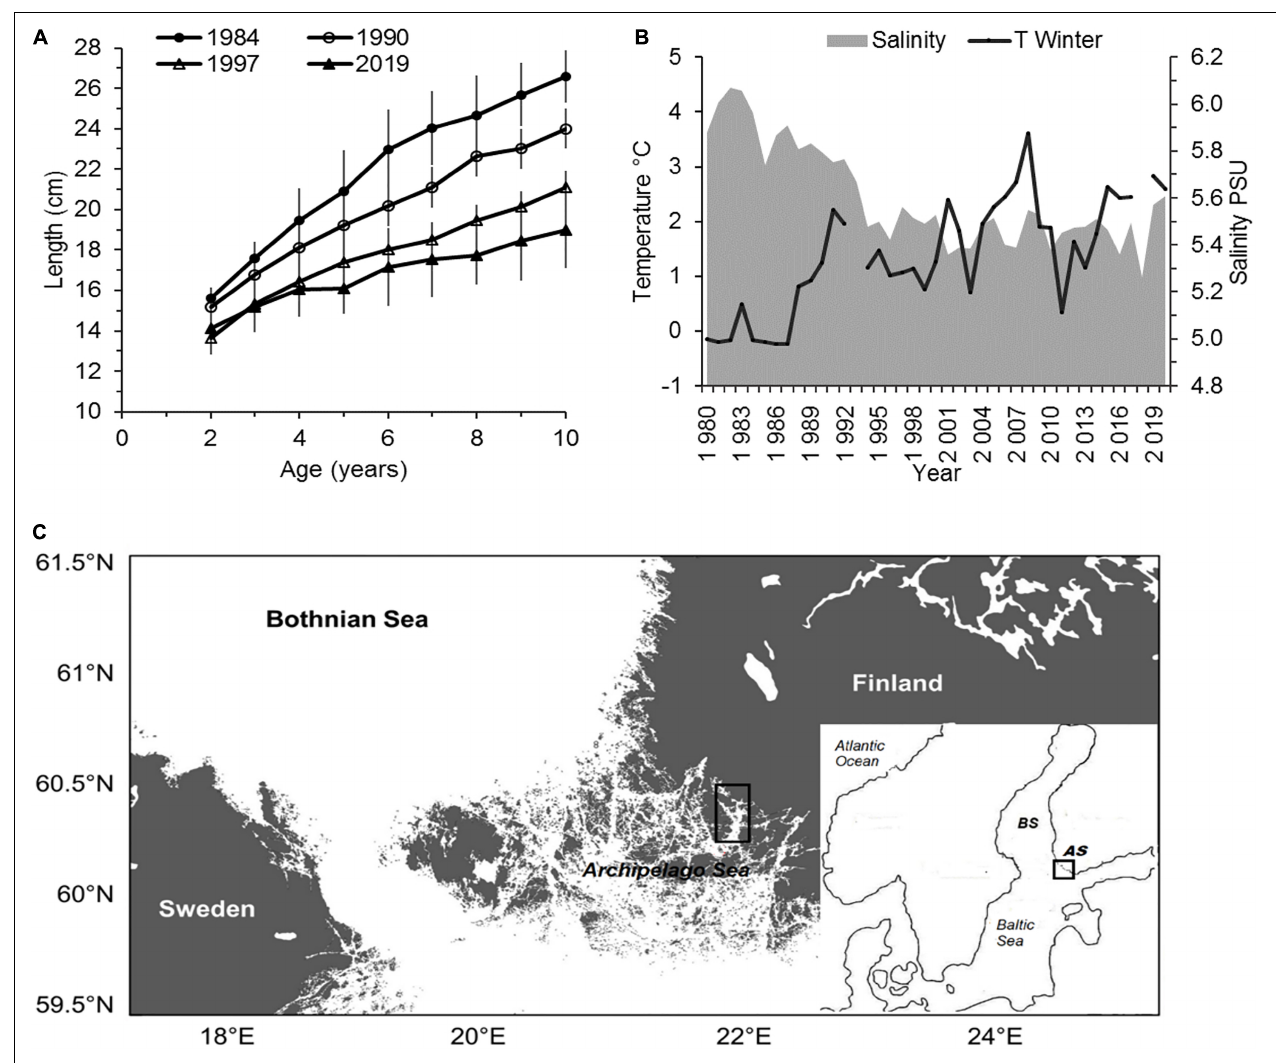
FIGURE 1 | (A) Length-at-age (cm) of spawning Baltic herring population in the Archipelago Sea in 1984, 1990, 1997, and 2019 at ages 2–10 years (mean with SD; own data); (B) salinity (PSU) and winter temperature ( ◦ C, mean in January–April at 0–50 m depth) in the Bothnian Sea during 1980–2019 (data source: https://www.ices.dk/data/data-portals/Pages/ocean.aspx); (C) the study area in the Archipelago Sea ( = AS; BS = the Bothnian